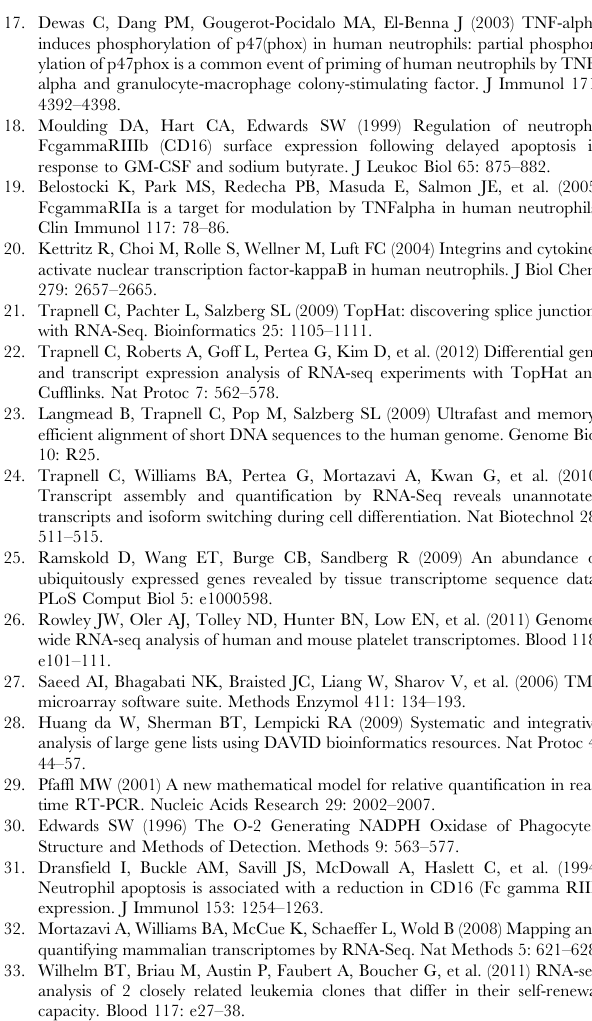
Table S2 Primer sequences used in real-time PCR. Table S3 Gene Ontology analysis of the genes signifi- cantly DE between GM-CSF treated neutrophils com- pared to TNF- a treated neutrophils. GO analysis was carried out using DAVID, and revealed significant enrichment of a number of GO categories relating to apoptosis (shown in bold) (FDR adjusted q-value #